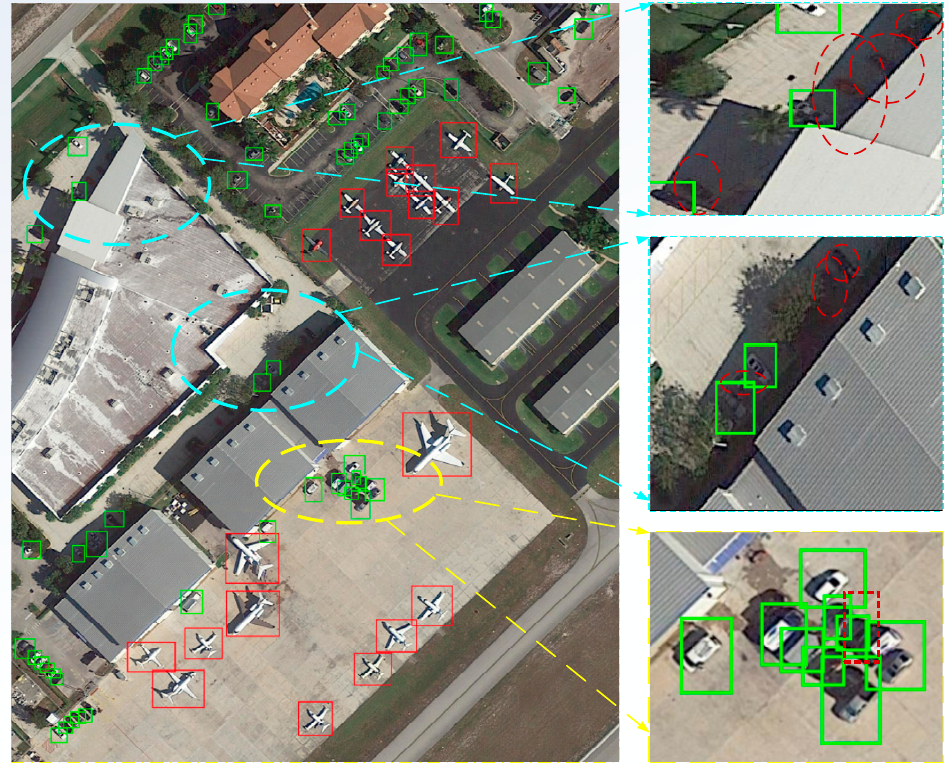
Figure 10. Some error results of our network.